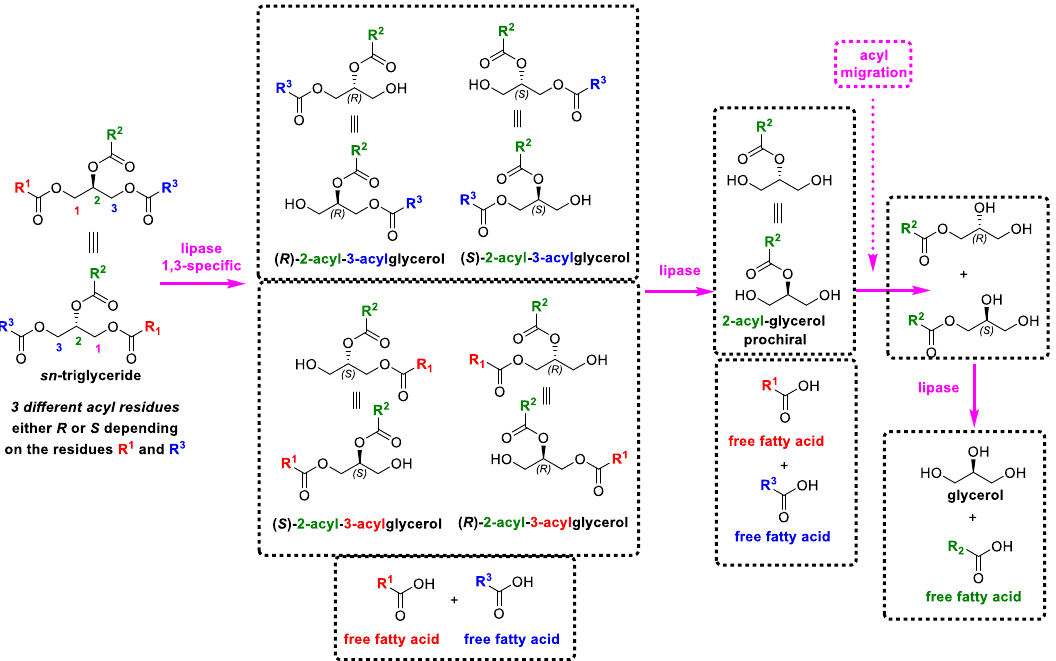
Figure 13. Full modification of triglycerides using a strict 1,3 lipase thanks to the acyl